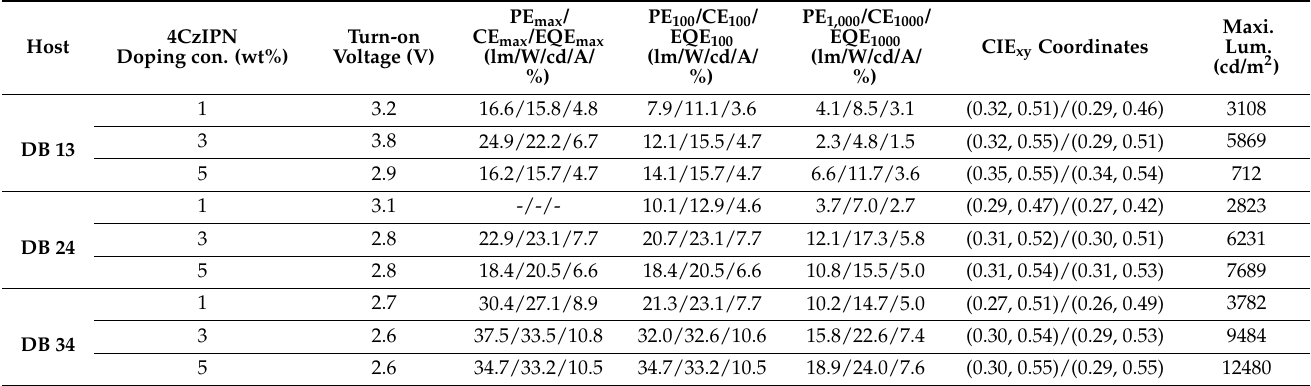
Table 4. Electroluminescent (EL) characteristics of the devices with hosts DB13, DB24 and DB34, doped with green commercial TADF emitter 4CzIPN at varying concentrations, displaying turn-on voltage, power efficacy, current efficacy, external quantum efficiency, CIE, and maximal luminance.